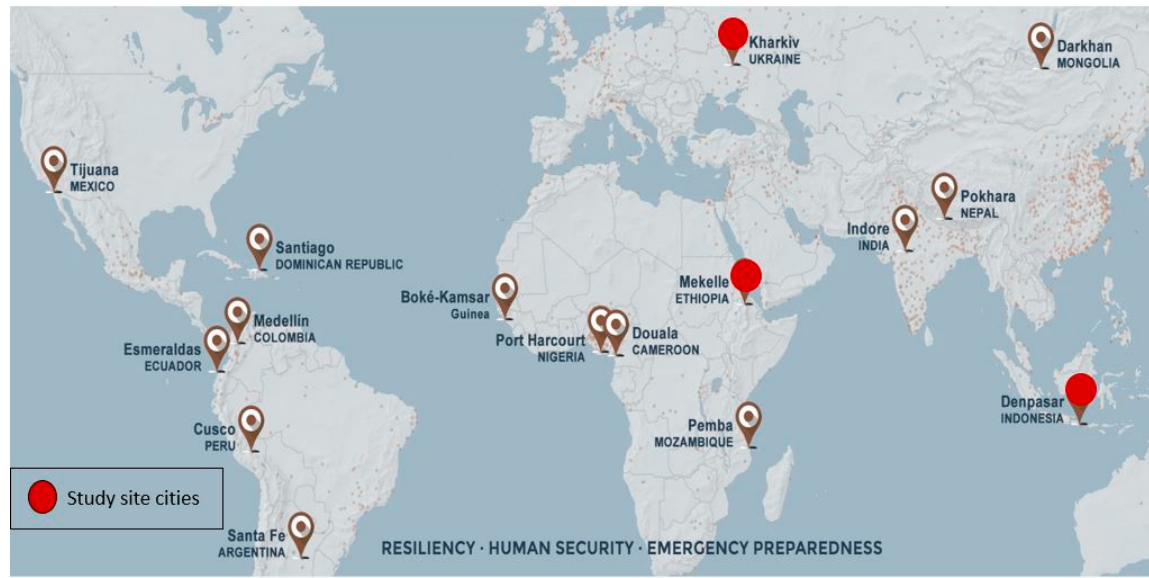
Figure 2. Secondary Cities (2C) Initiative cities with study site cities identified.